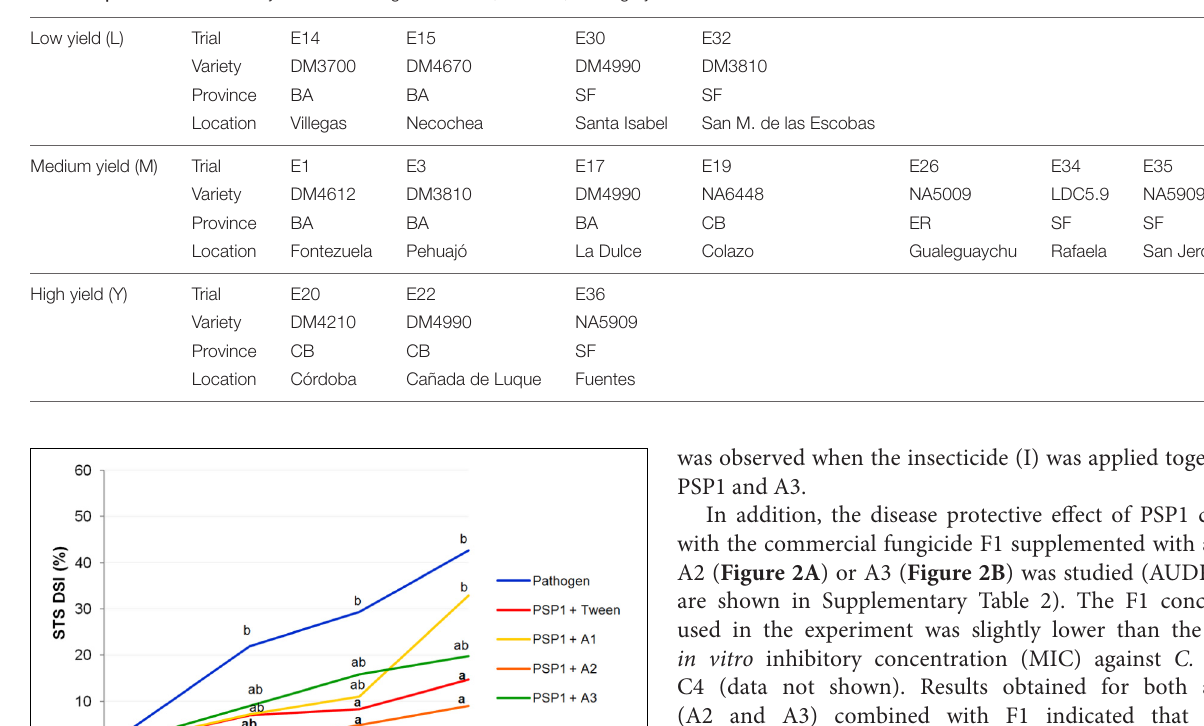
TABLE 1 | Characteristics of soybean trials categorized in low, medium, and high yield.